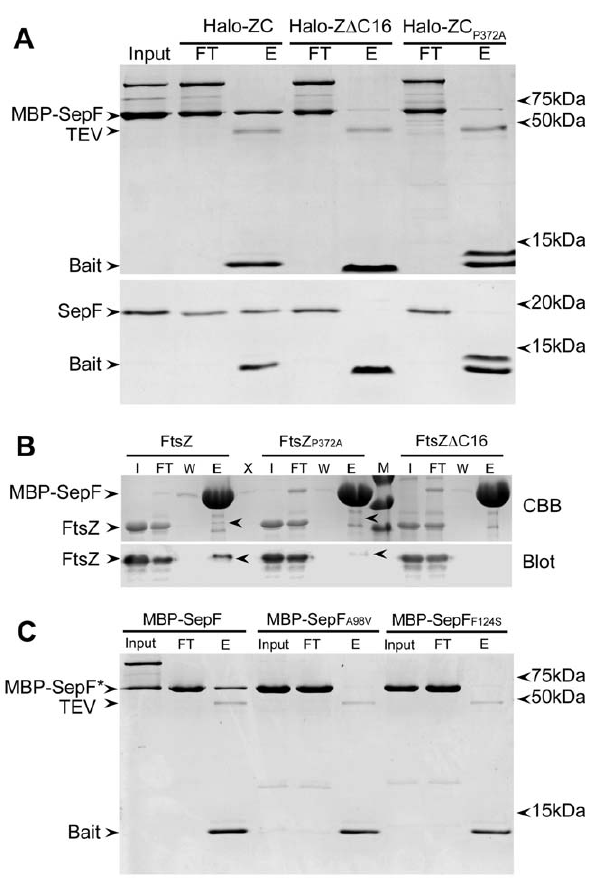
Figure 2. Specificity of the interaction between SepF and the FtsZ C-terminus. (A) Pull down experiments using Halo-ZC, Halo Z D C16 or Halo-ZC P372A bound to resin, with MBP-SepF (upper panel) or wild type SepF (lower panel) as prey proteins. The input material (Input), flow-through (FT) and eluate (E) fractions of the experiments are shown and relevant proteins are indicated on the left. MBP-SepF tends to form dimers as can be observed from the extra band in the input and flow-through samples. (B) Reverse pull down experiment with MBP- SepF bound to resin and purified FtsZ, FtsZ P372A or FtsZ D C16 used as prey proteins. The input material (I), flow-through (FT), last wash (W) and eluate (E) fractions of the experiments are shown and relevant proteins are indicated on the left. M: molecular weight marker, bands are 70, 55 and 40 kDa. Upper panel: Coomassie stained gel (CBB), lower panel: western blot developed with anti-FtsZ antibody. (C) Pull down experiments using Halo-Zc bound to resin, with MBP-SepF, MBP- SepF A98V and MBP-SepF F124S as prey proteins. The input material (Input), flow-through (FT) and eluate (E) fractions of the experiments are shown and relevant proteins are indicated on the left.